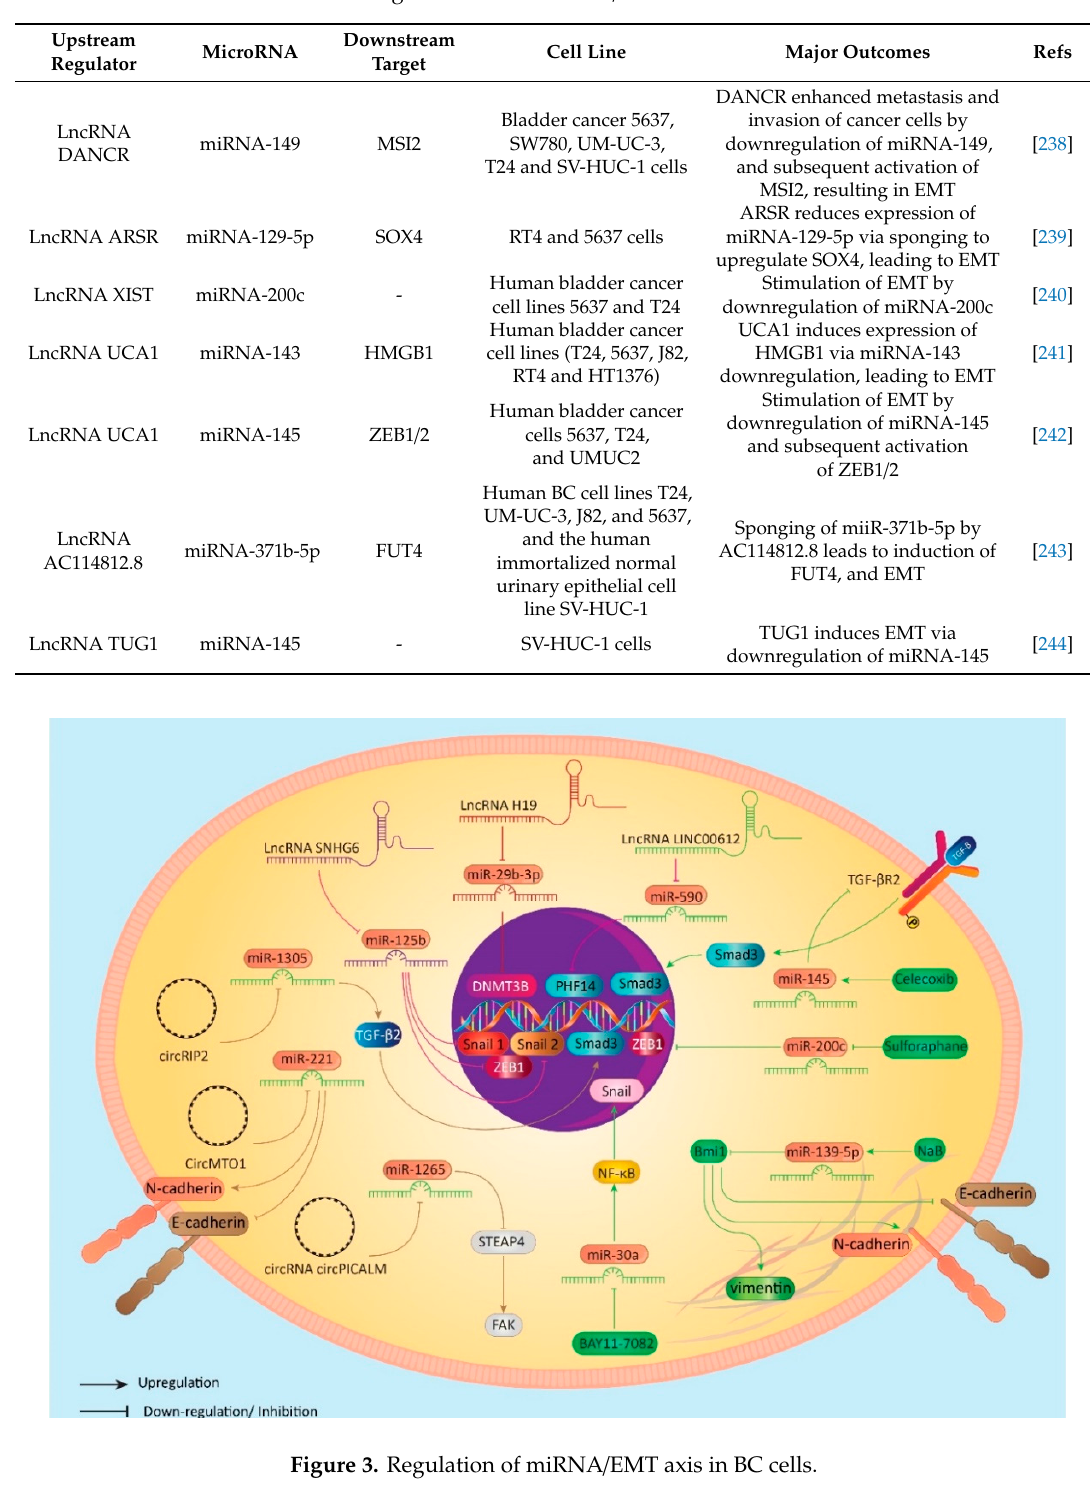
Figure 3. Regulation of miRNA/EMT axis in BC cells.